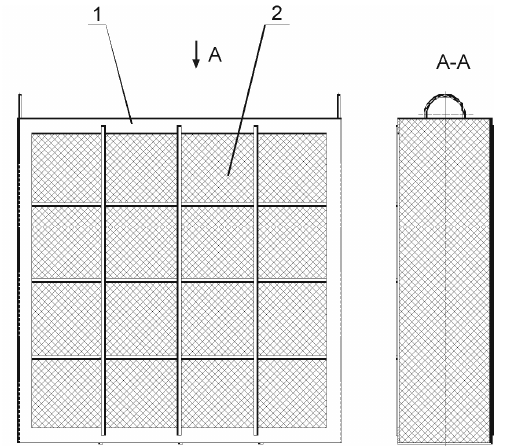
Fig. 2. Cassette with metal mesh of knitted weave: 1 – framework; 2 –